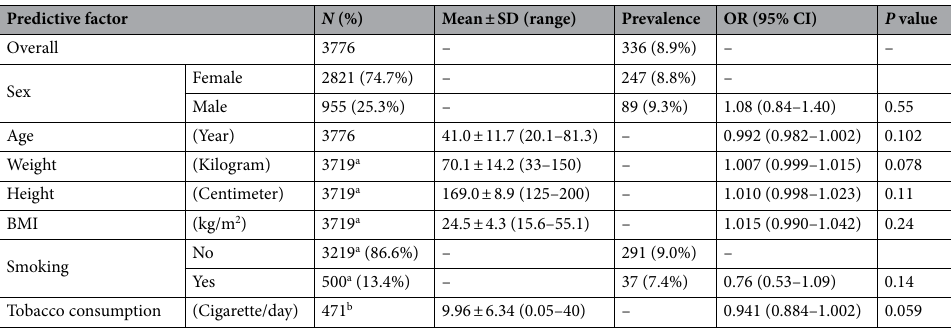
Table 1. Predictors of SARS-Cov-2 positive serology (IgG DiaSorin) in phase1: subject characteristics. Place of residence, specific workplace, number/country/period of travel abroad, and type of mask used were also tested and found not significant. SD: standard deviation; BMI = body mass index; OR = odds ratio of univariate logistic regression models adjusted for time between March 1 and testing; CI = confidence interval. a 57 subjects did not consent to sharing personal health data. b 29 subjects who reported being smokers did not share their tobacco